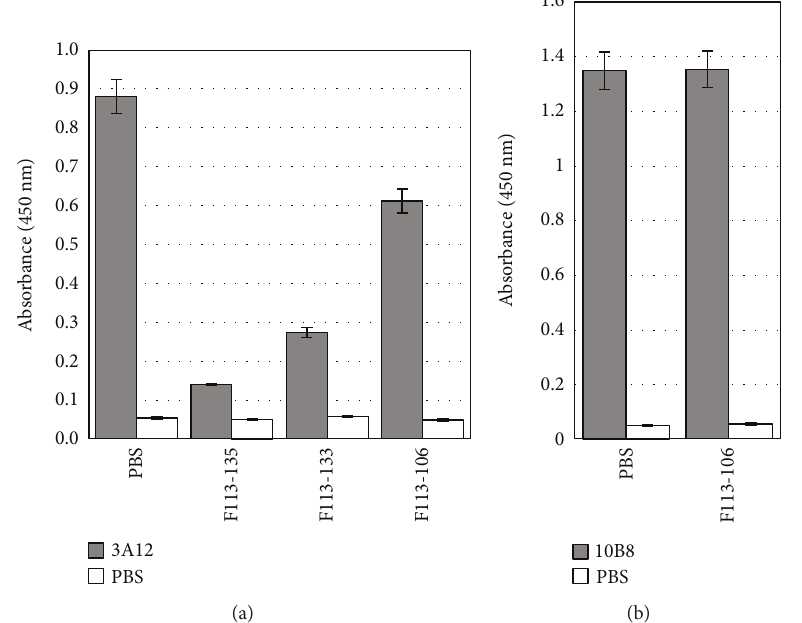
Figure 7: Competitive ELISA with mouse mAbs 3A12 and 10B8. (a) The binding activity of 3A12 to B/Massachusetts/2/2012 was examined in the presence of excess Fab-cp3 form of three anti-HA Abs, F113-135, F113-133, and F113-106. (b) The binding activity of 10B8 to B/ Brisbane/60/2008 was examined in the presence of excess